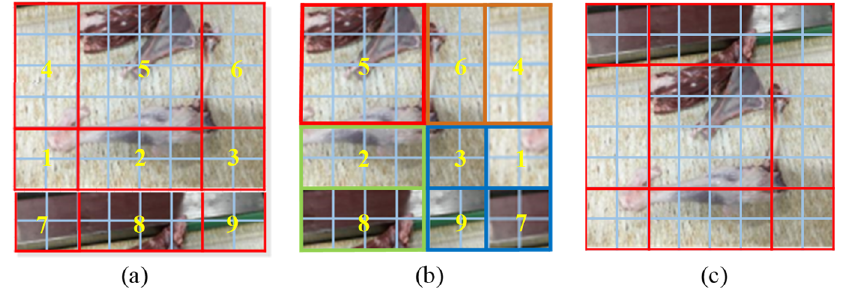
Figure 6. Swin-Transformer SW-MSA Shift configuration batch calculations. Note: ( a – c ) represent the three stages of the Shift configuration batch calculations process in Shifted Window Muti-head Self-Attention structure,